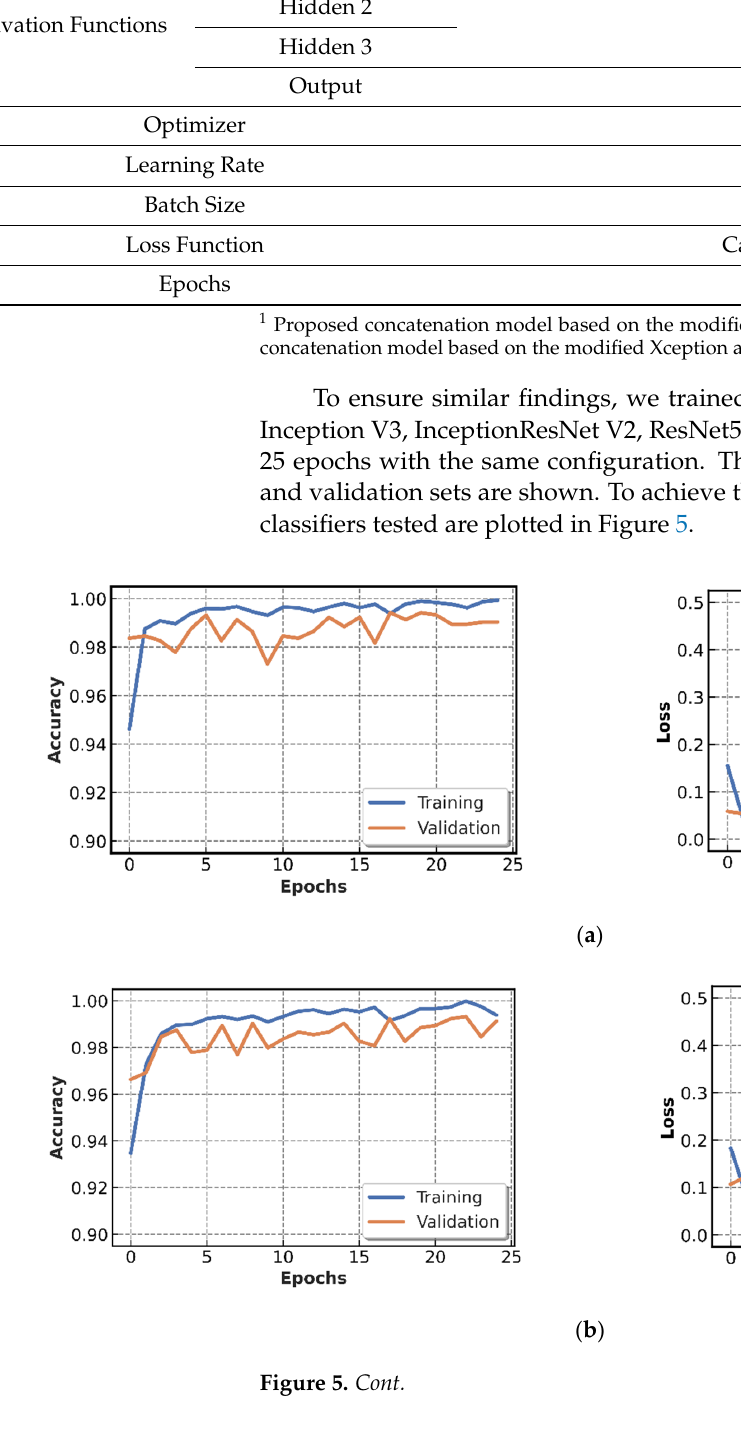
Table 13. The best hyper-parameters were used for the modified models and the two proposed concatenation models in the training phase.